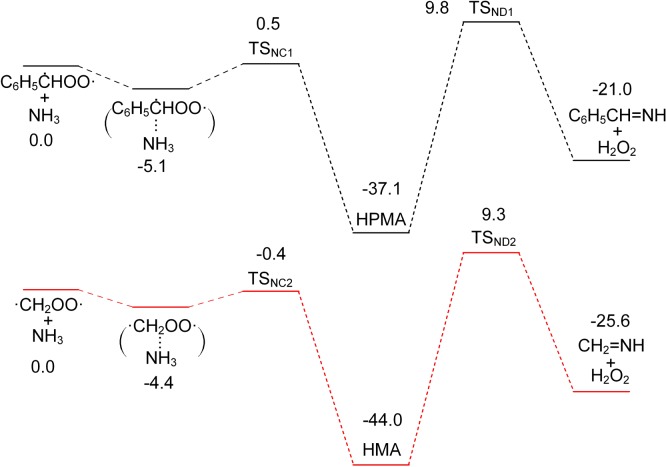
Potential energy surface (kcal mol−1) of C6H5ĊHOO· + NH3 and ·CH2OO· + NH3 calculated at the CBS-QB3 level.